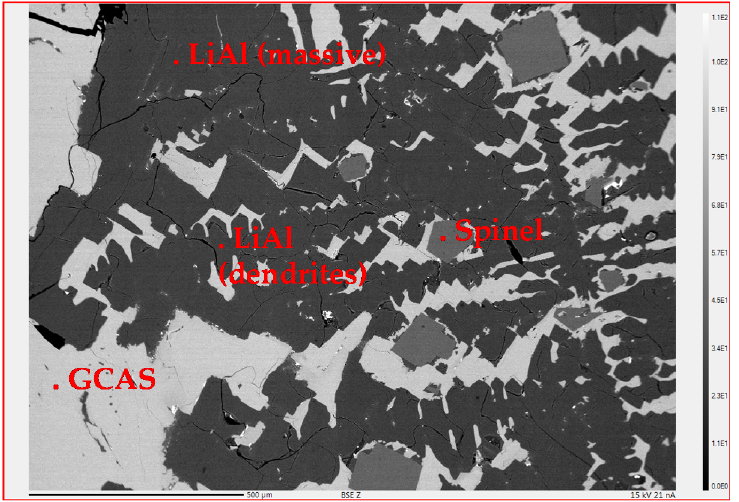
Figure 3. Electron micrograph (BSE(Z) of the solidified melt. Medium grey grains, spinel; dark gray sections and dendrites, LiAl surrounded by Ca-alumosilicate (GCAS, light grey sections); black, pores or preparation damage.